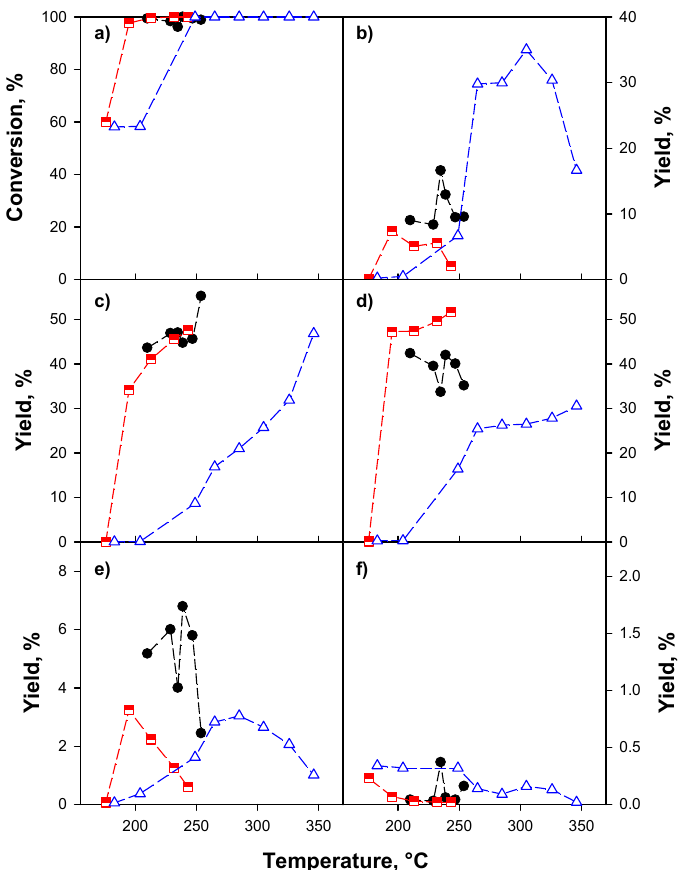
Figure 7. ( a ) Glycerol conversion, ( b ) yields to acrolein as a function of temperature at different contact times: 0.043 (full symbols), 0.057 (semi-filled symbols), 0.088 (open symbols) g·s·cm − 3 ; Gly/H 2 O/O 2 /N 2 = 2/41/6/51 vol. %.